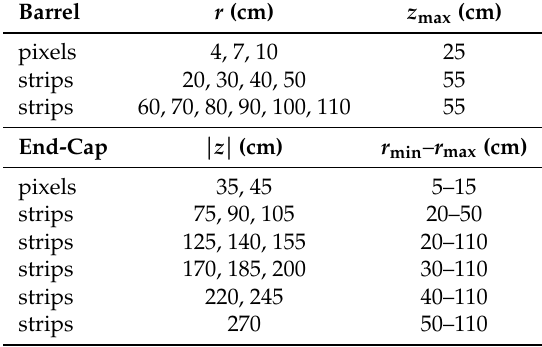
Table 1. Main characteristics of tracking detector (silicon layers) used in the simulation. For the barrel layers, the layer type is shown along with the radii ( r ) of the concentric cylinders and their longitudinal extent ( − z max – z max ) in the beam direction. For the end-cap layers, the layer type is shown along with their | z | positions and with the inner ( r min ) and outer radii ( r max ) of their